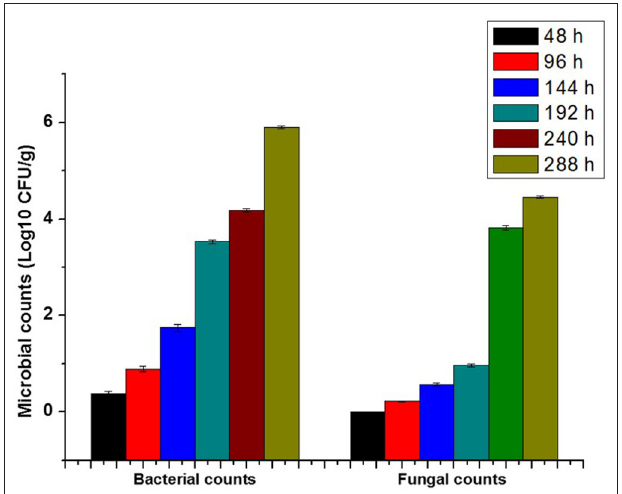
FIGURE 3 | Microbial population over 12 days for cooling fresh fish filet. FIGURE 5 | The smart packages during the storage period of fresh fish filet.